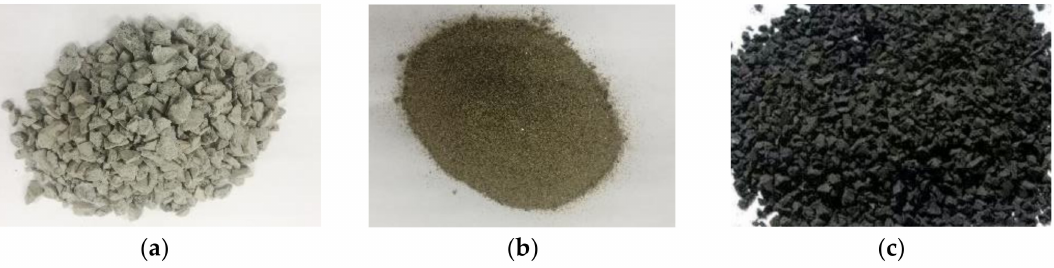
Figure 3. Photos of aggregates: ( a ) stone; ( b ) sand; ( c ) crumb rubber.